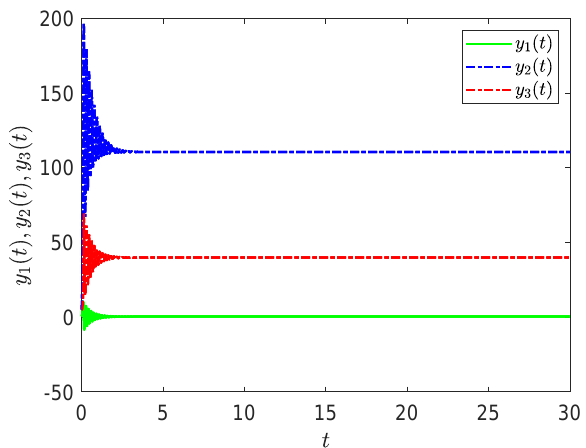
Figure 29. Solution profiles of the Glukhovsky–Dolzhanksy system of